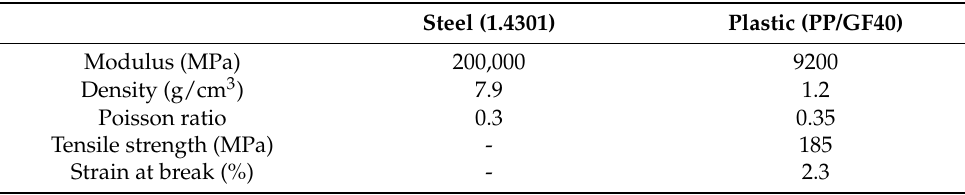
Table 2. Material properties of the metal and plastic